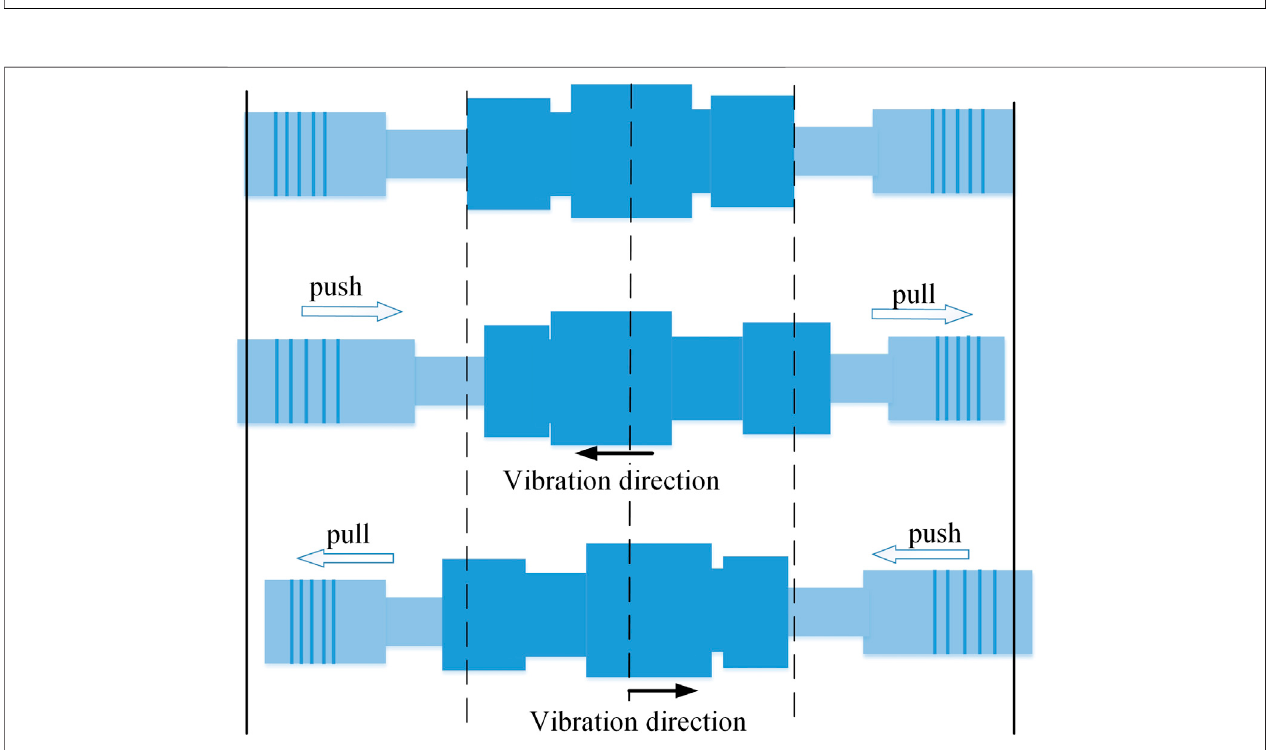
FIGURE 3 | Working principle of sonotrode